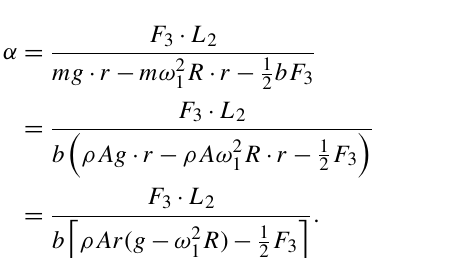
Figure 3. Diagram of the shape of a hammer slice.